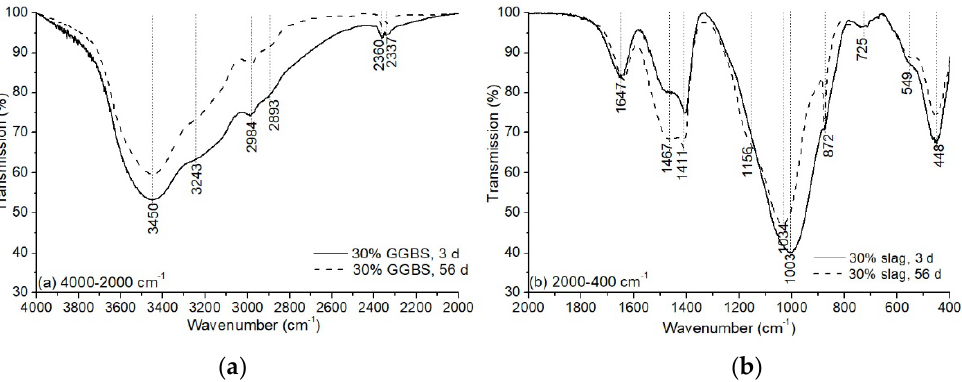
Figure 10. Fourier transform infrared (FTIR) spectrum of alkali-activated LFA-GGBS hybrid binders (Na 2 O content 10%, n = 1.6, and w / s = 0.4, 30% GGBS): ( a ) 4000–2000 cm − 1 ; ( b ) 2000–400 cm − 1 . Table 3. Peak properties after deconvolution of alkali activated LFA-GGBS hybrid binders (Na 2 O